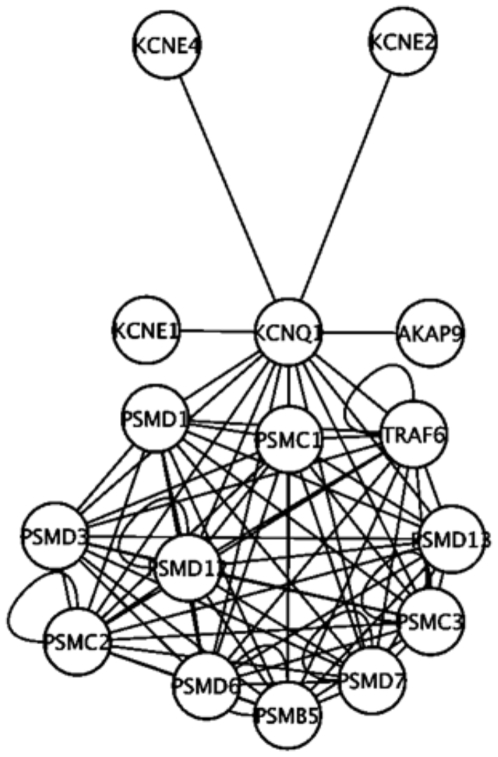
KCNQ1 -protein interaction analyses as estimated from bioinformatics-driven protein-protein network analyses including interactions transferred from other organisms by orthology.PSMC x - Proteasome 26S subunit, ATPase, x; PSMD x – Proteasome 26S subunit, ATPase, x; PSMB5 – Proteasome subunit, beta-type, 5; AKAP9 – A-Kinase Anchor Protein 9; KCNE x – Potassium Channel, Voltage-gated, ISK-related Subfamily, Member x.